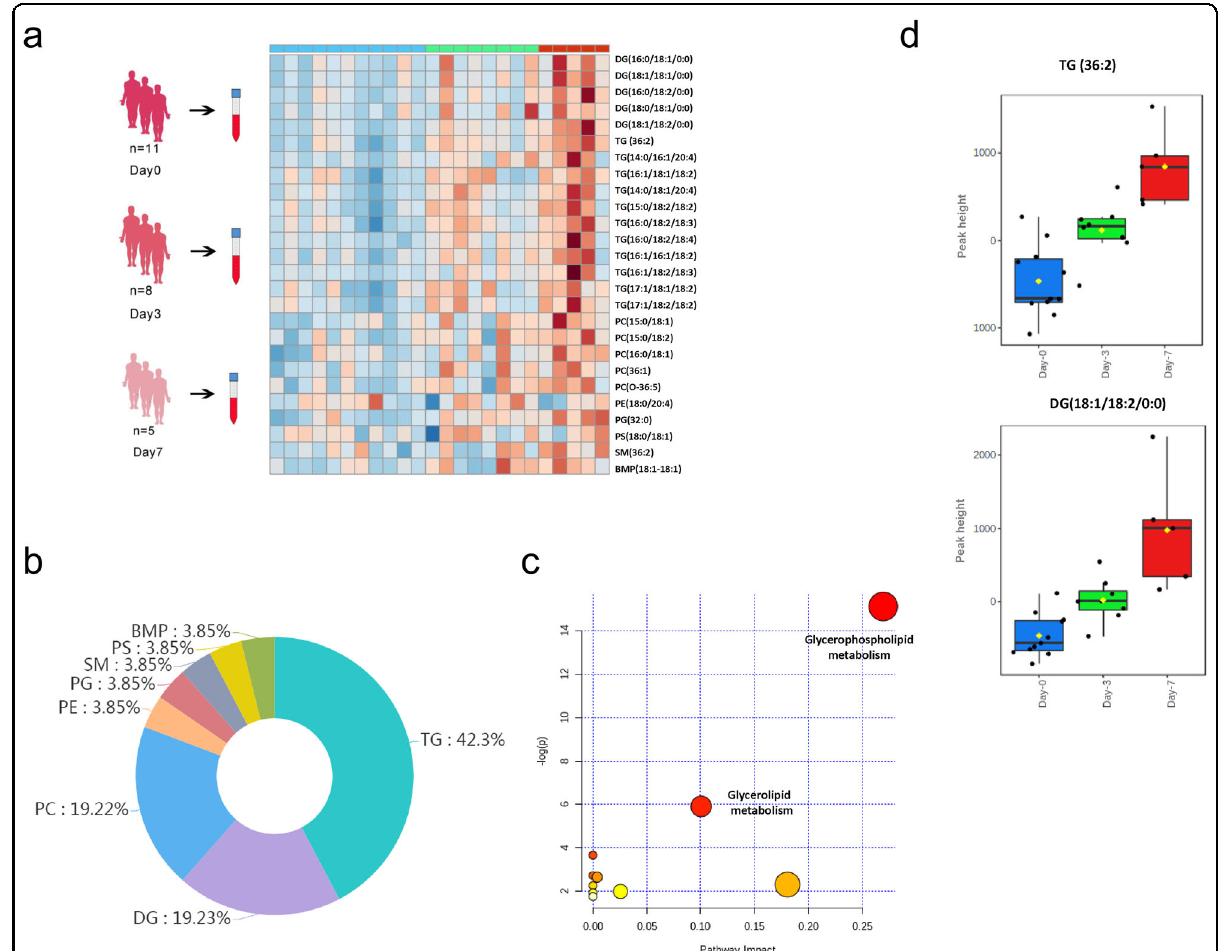
Fig. 1 Plasma lipidome of COVID-19 patients. a Lipidome of COVID-19 patients ’ plasma samples over the disease course. All blood samples were collected before the patients ’ discharge from the hospital. Day 0 means the fi rst day of patient hospitalization and blood taking. The hierarchical clustering analysis was based on the identi fi ed lipid metabolites with signi fi cant changes in quantity, comparing with Day 0. Each rectangle represents a lipid colored by its normalized intensity scale from blue (decreased level) to red (increased level). b Pie chart showing the relative ratio of eight lipid classes that are signi fi cantly perturbed. These lipids belong to BMP bismono-acylglycerophosphate. DG diacylglycerol, PC glycerophosphocholines, PE glycerophosphoethanolamines, PG glycerophosphoglycerols, PS glycerophosphoserines, SM sphingomyelin, TG triacylglycerol. c Overview of pathway analysis based on the identi fi ed lipids. The y -axis, “ -log(p) ” , indicates the log 10 transformed p -value after enrichment analysis; the x -axis, “ Pathway Impact ” , represents the value calculated from the pathway topology analysis. d Boxplots illustrate the top two dominant perturbed lipid class representatives in the time-course study, DG (18:1/18:2/0:0) ( P = 0.0097, day 0 vs day 7) and TG (36:2, day 0 vs day 7) ( P = 0.0084). y -Axis represents the peak height of selected lipids based on the LC – MS